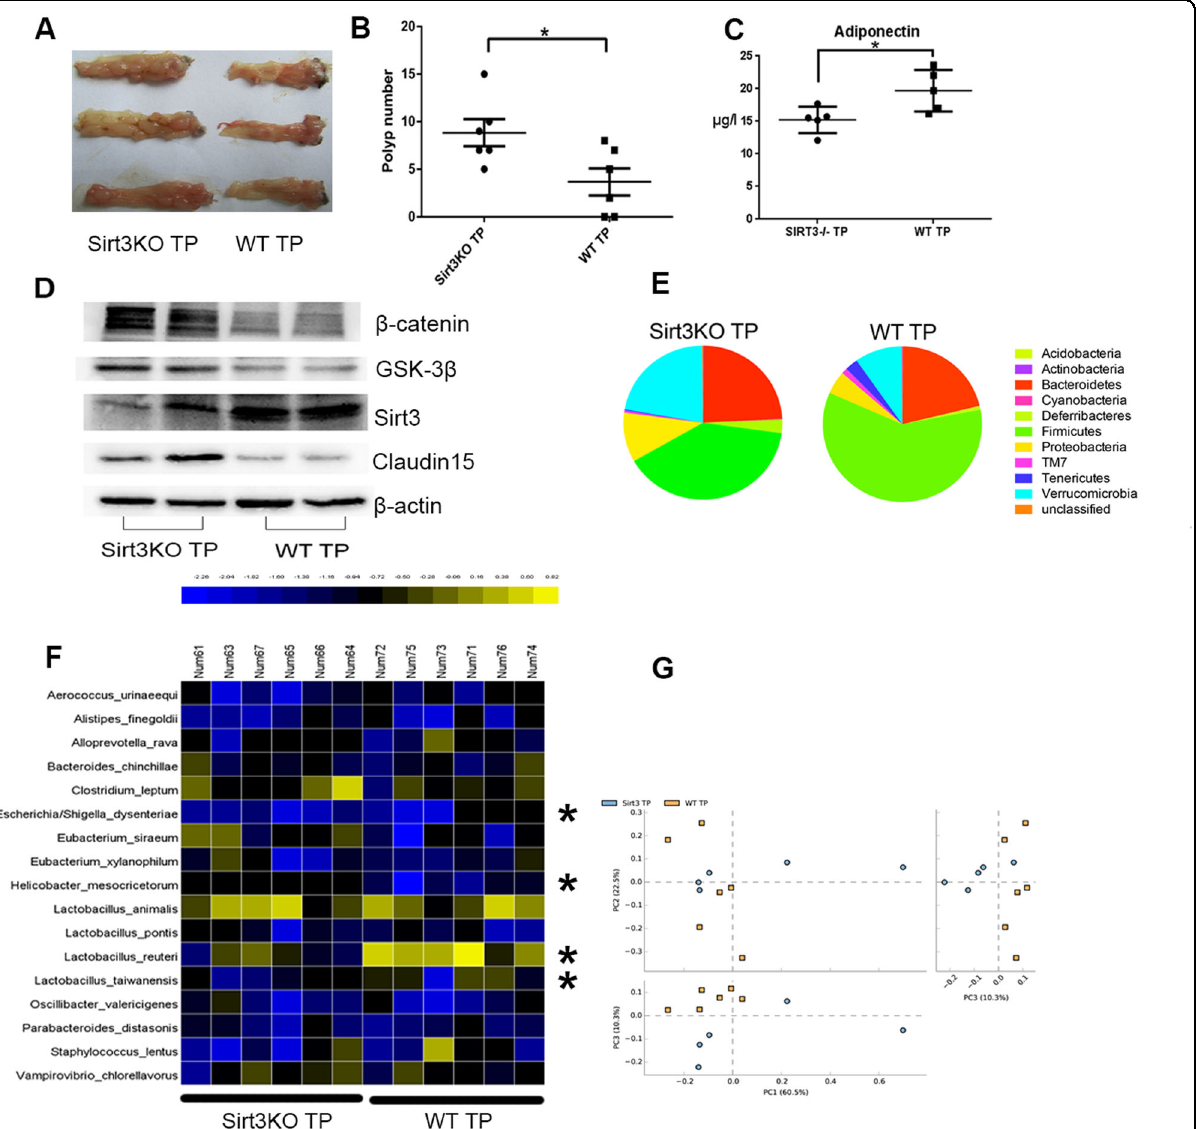
Fig. 5 High and low Sirt3 expression modi fi ed by microbiome transfer have different effects on colon tumorigenesis. a Images of distal colons from SIRT3KO TP and WT TP mice after AOM/DSS tumorigenesis. b Comparison of polyp numbers between SIRT3KO TP and WT TP mice ( n = 6). Data are represented as the mean ± SEM. P < 0.05; ** P < 0.01; *** P < 0.001; by unpaired Student ’ s t test. c Western blots of intestinal SIRT3, GSK3 β , β -catenin and Claudin15 expression from SIRT3KO TP and WT TP mice after AOM/DSS tumorigenesis. d Comparison of serum adiponectin levels between SIRT3KO TP and WT TP mice ( n = 5 – 6). Data are represented as the mean ± SEM. P < 0.05; ** P < 0.01; *** P < 0.001; by